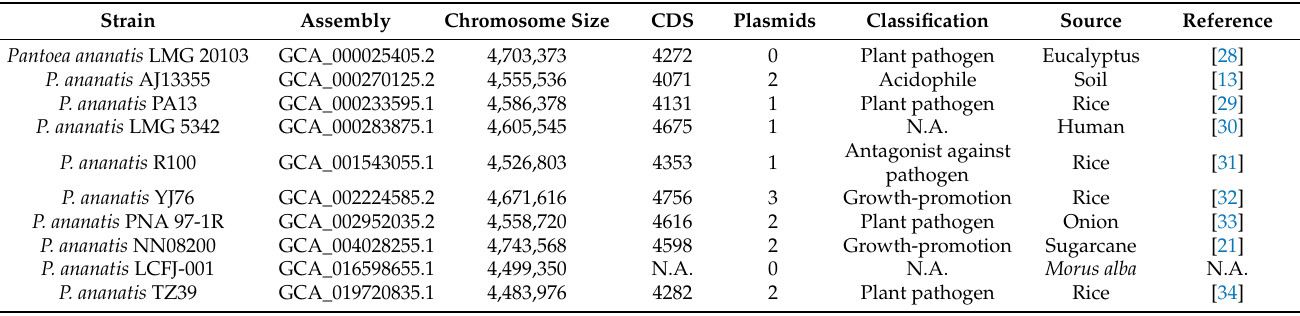
Table 1. Complete genome of Pantoea ananatis